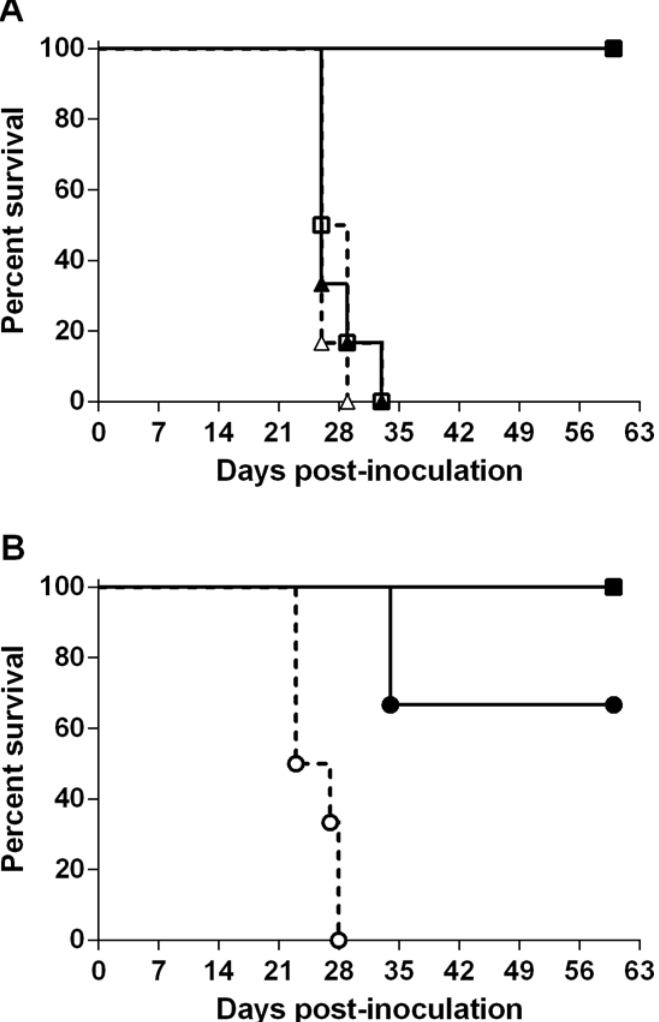
wildebeest (triangles) or plasma from sheep (squares). B) Survival curves of rabbits inoculated with OvHV-2 incubated with sera from goats (circles) or plasma from sheep (squares). Closed symbols represent rabbits inoculated with OvHV-2 incubated with MCFV antibody positive sera (Ab+); open symbols represent rabbits inoculated with MCFV antibody negative sera or plasma